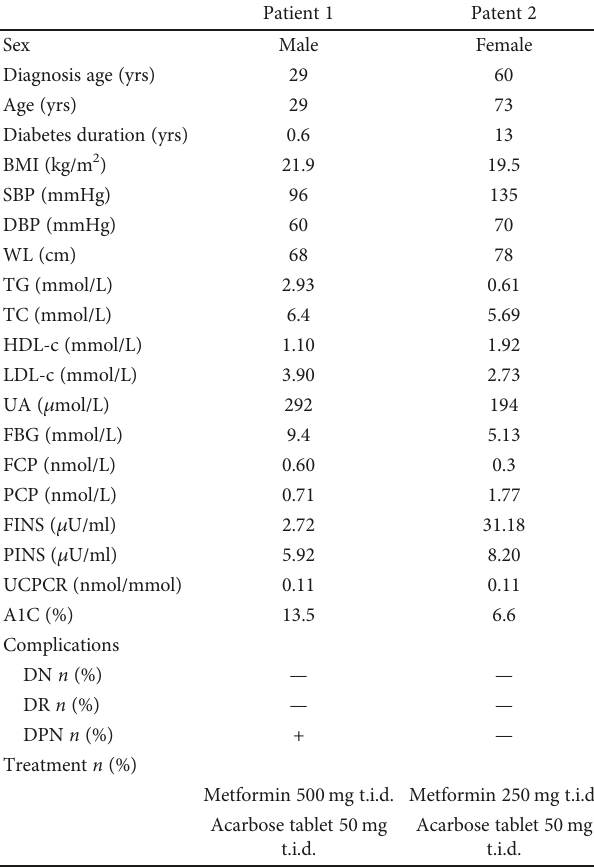
Table 3: The characters of the two patients who had a UCPCR < 0 20nmol/mmol and without insulin or secretagogue